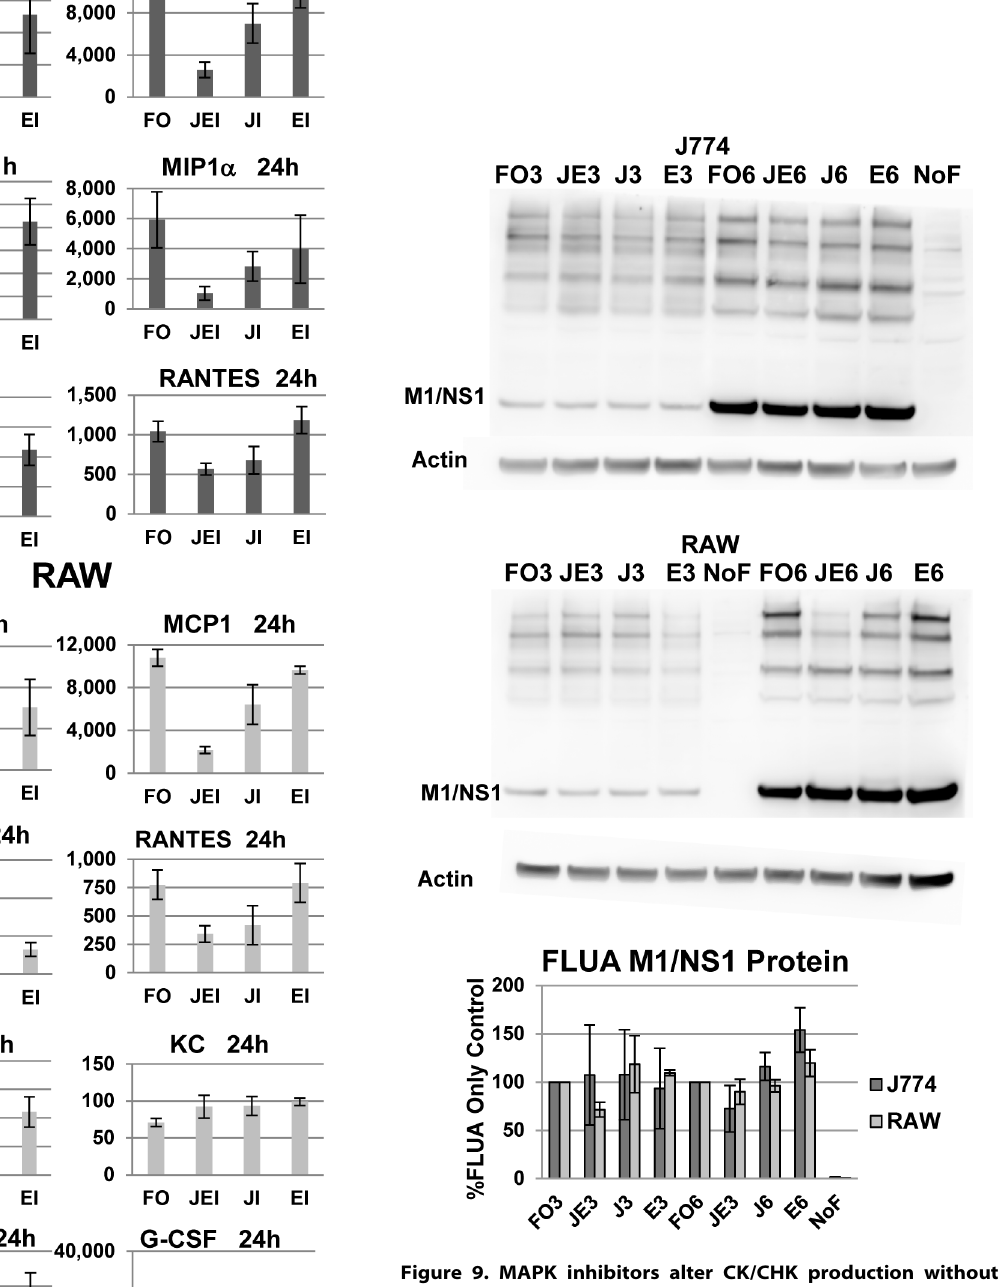
Figure 9. MAPK inhibitors alter CK/CHK production without reducing viral protein production in either cell type. As MAPK inhibition did not substantially block FLUA protein production the decreased CK/CHK production is not due to a direct anti-viral effect of the inhibitors. Representative Western blots of FLUA proteins. Densitometry values shown are the percent protein produced by the inhibited cells compared to the infected, uninhibited cells at the corresponding time points; mean percentage 6 SEM, n=3 indepen- dent experiments. FO3–FLUA only 3 h pi; JEI3–both JNK and ERK inhibition 3 h pi; JI3–JNK inhibition 3 h pi; EI3–ERK inhibition 3 h pi; NoF–mock infected cells with no inhibitors (treated with DMSO); FO6– FLUA only 6 h pi; JEI6–both JNK and ERK inhibition 6 h pi; JI6–JNK inhibition 6 h pi; EI6–ERK inhibition 6 h pi.